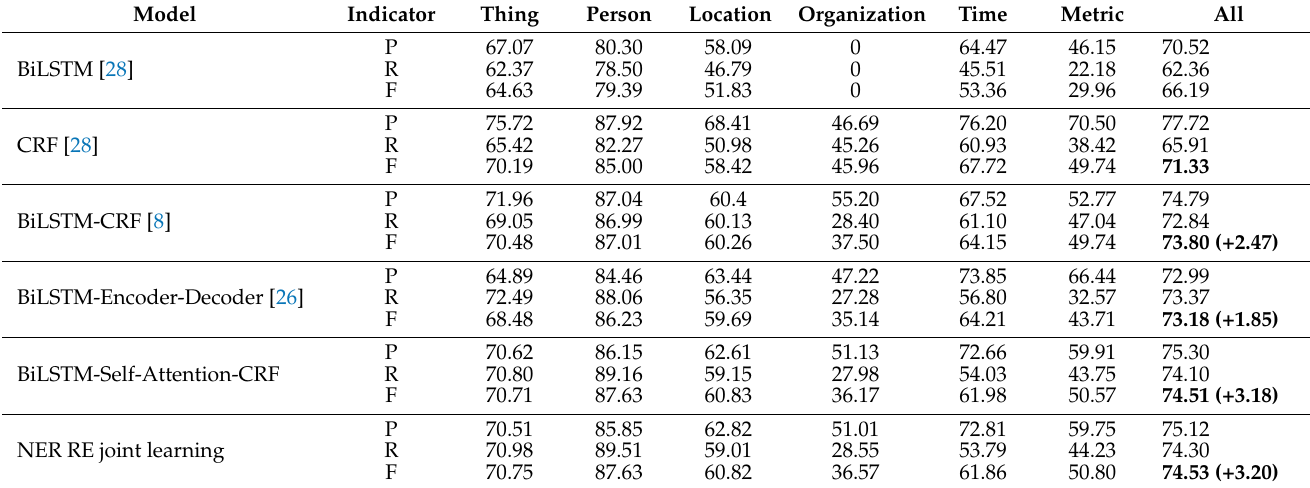
Table 5. Results of named entity recognition.